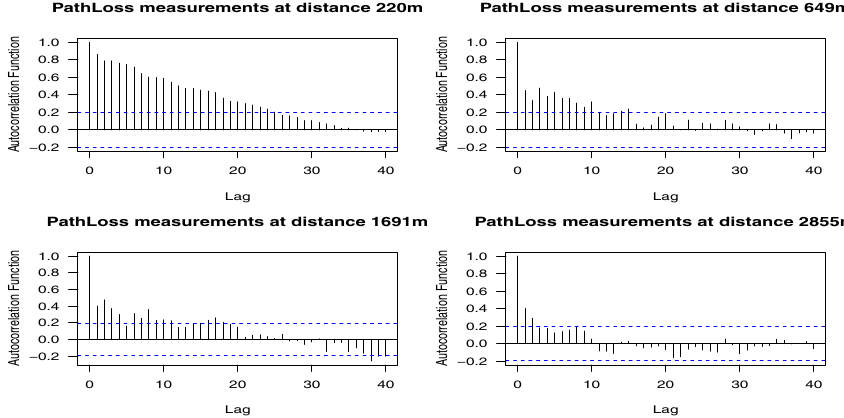
Fig. 1 Sample autocorrelation function of path loss measurements at various